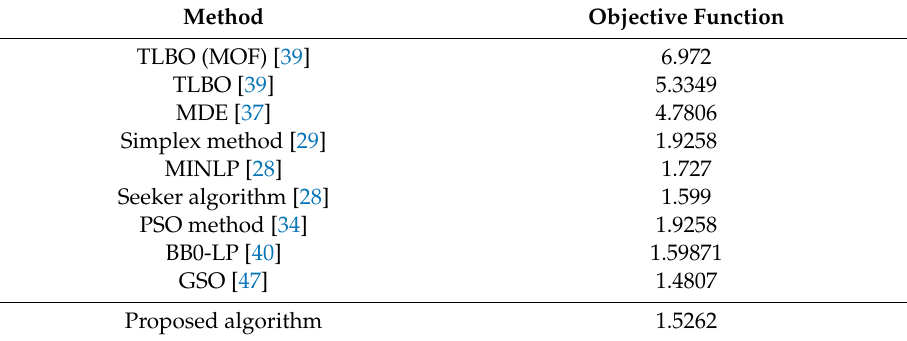
Table 3. Comparison of the WOA result with the literature for the IEEE three-bus